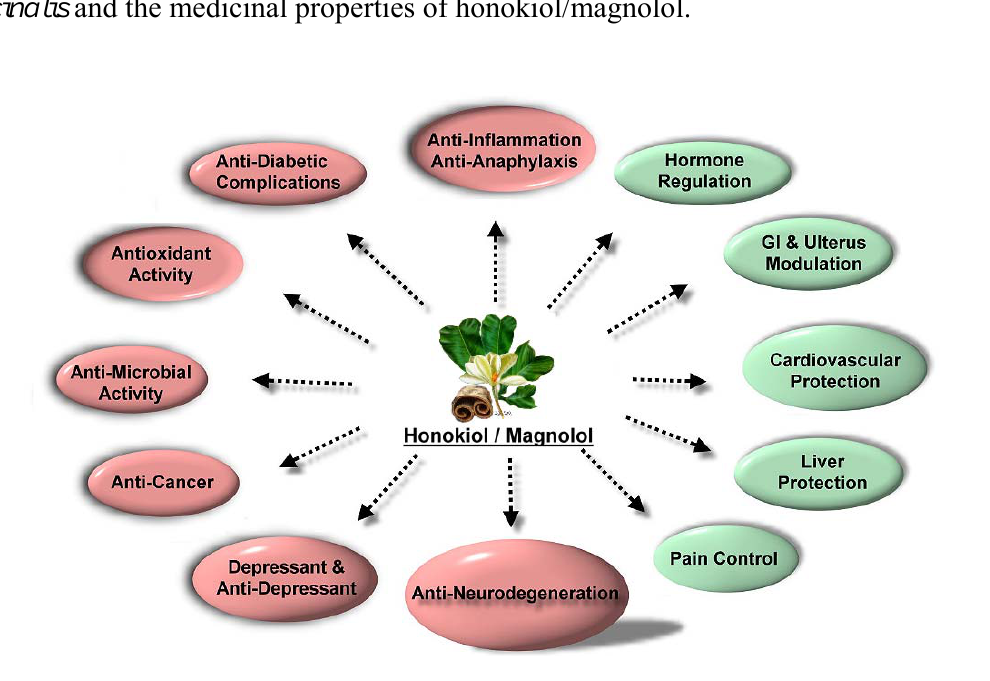
Figure 2. The flower, leaf, and bark of traditional Chinese medicinal plant Magnolia officinalis and the medicinal properties of